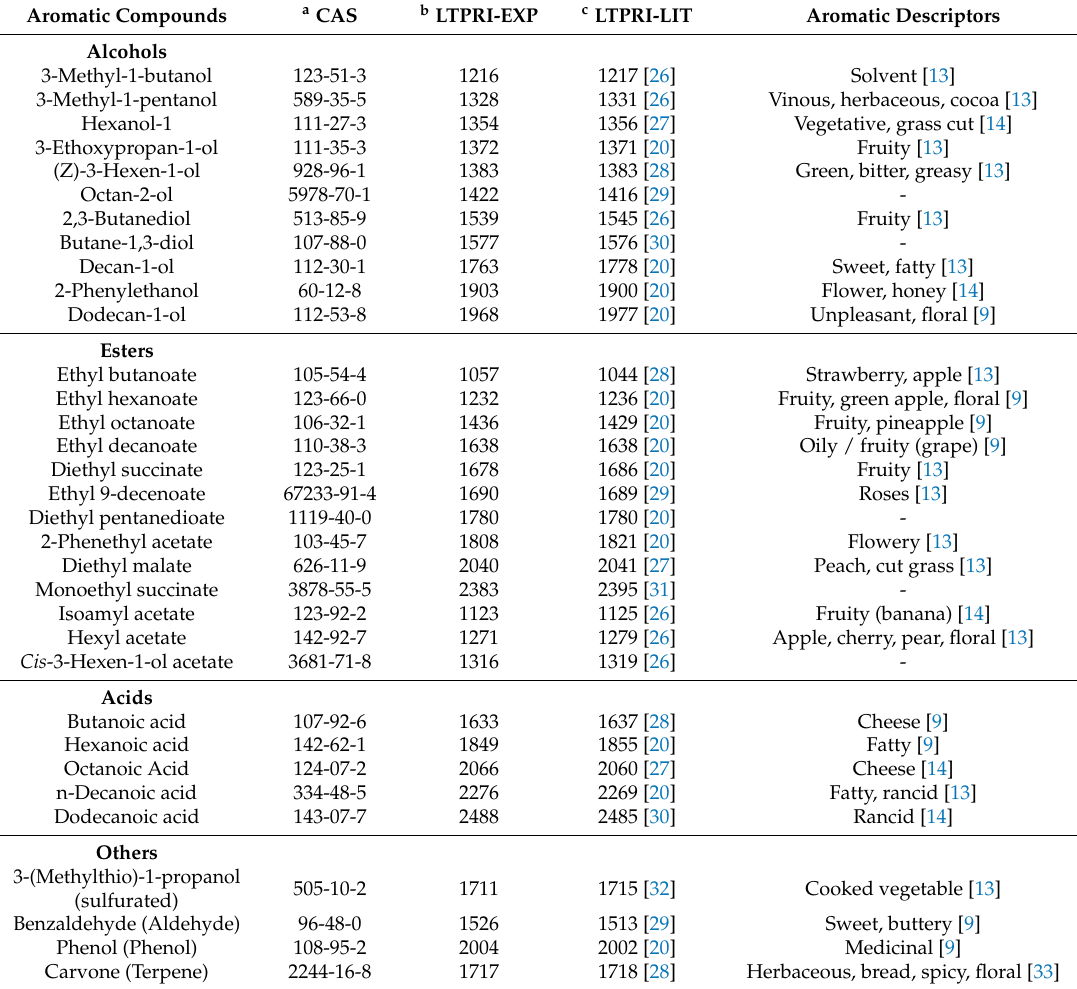
Table 2. Volatile compounds tentatively identified in four sparkling wines elaborated by traditional method in the SFV and its aromatic